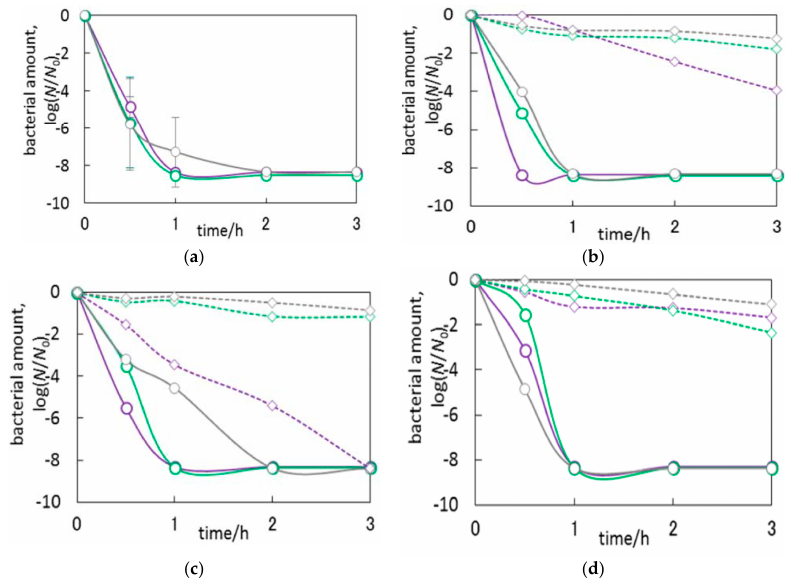
Figure 29. Survival of E. coli in CFU/mL treated with ( a ) Cu 2 O, ( b ) Cu 2 O/anatase TiO 2 , ( c ) Cu 2 O/P25, and ( d ) Cu 2 O/rutile TiO 2 in solid curves with circle symbols; grey color (dark condition), violet (UV irradiation) and green (visible light). Umodified anatase TiO 2 , P25 and rutile TiO 2 results are shown in dashed curves with diamond symbols in grey (dark condition), violet (UV irradiation) and green (visible light). Error bars in Cu 2 O: standard deviation determined from two or three independent measurements. Reproduced with permission from [177]. Copyright MDPI, 2018.